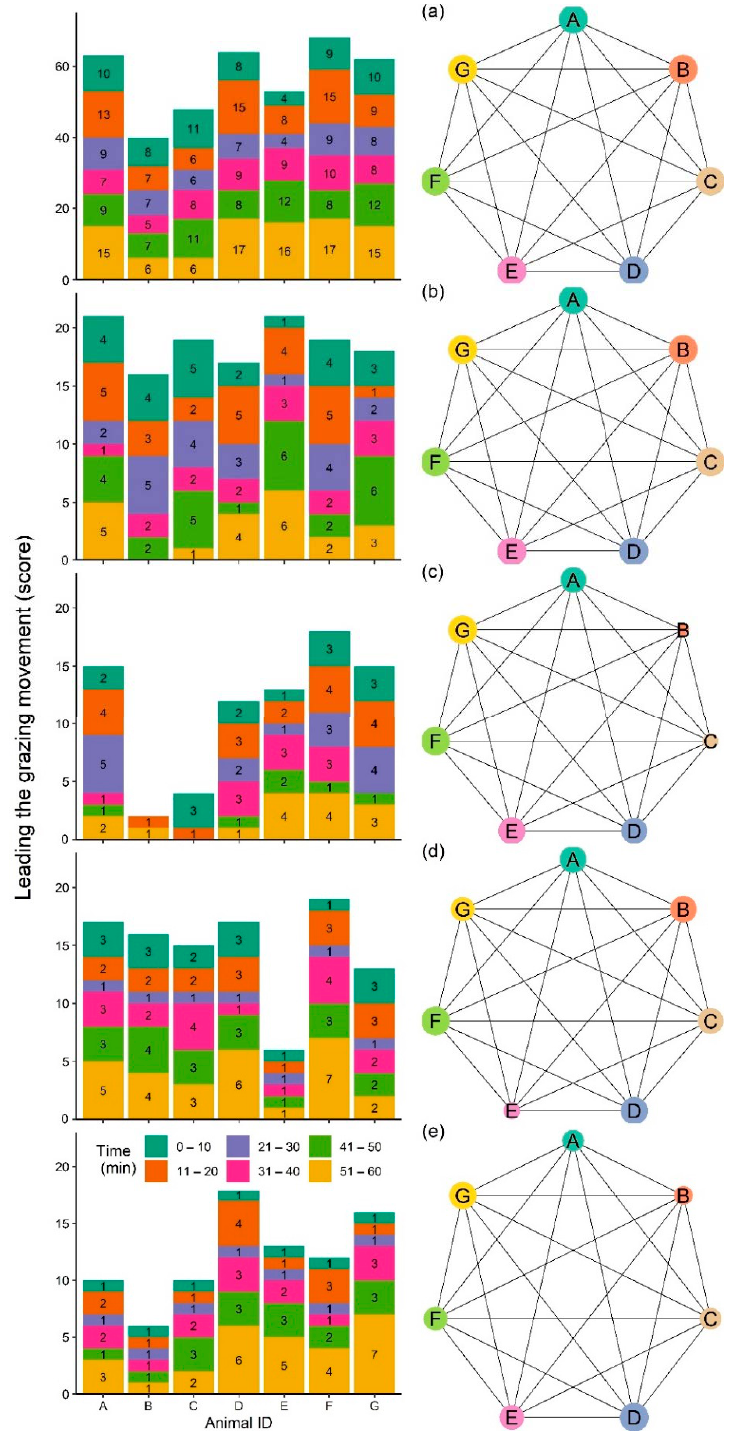
Figure 11. The pattern over time of individual gazing movement leader scores ( a ) summed for the total four-hour period during days 2 and 3; ( b , c ) first and second hour on day 2, and ( d , e ) first and second hour on day 3 presented as bar charts showing the individual movement rank for each 10 min period per hour of study ( b – e ) or the total score for 4 study hours ( a ) in which the animal (s) with the highest movement score moved first within each specific time point. A corresponding social network for each bar chart is also displayed (the larger vertex corresponds with an individual’s higher rank). Letters in the vertices refer to individual animals.